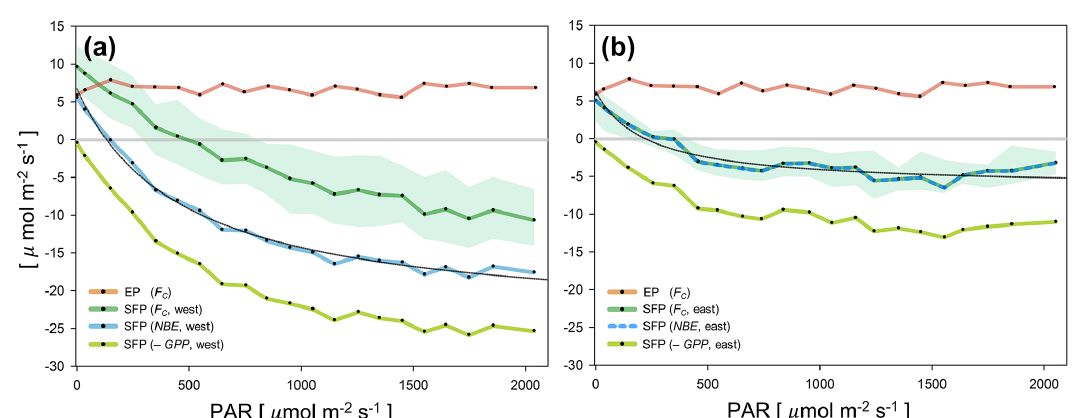
Figure 11. During the growing season (June–August 2013, 2014) when E B is negligible, light-response curves as a function of photosyn- thetically active radiation (PAR, in bins of 100µmolm − 2 s − 1 ): (a) for the western sectors (150 ◦ <(cid:56)< 300 ◦ ) and (b) for the eastern sectors (30 ◦ <(cid:56)< 90 ◦ ). Black line is a rectangular hyperbolic equation fitting net biome exchange (NBE = RE − GPP = F C − E R ) to PAR, and EP (brown line) is a light-response curve for the high-rise, high-population residential area in Seoul. The shaded areas indicate interquartile